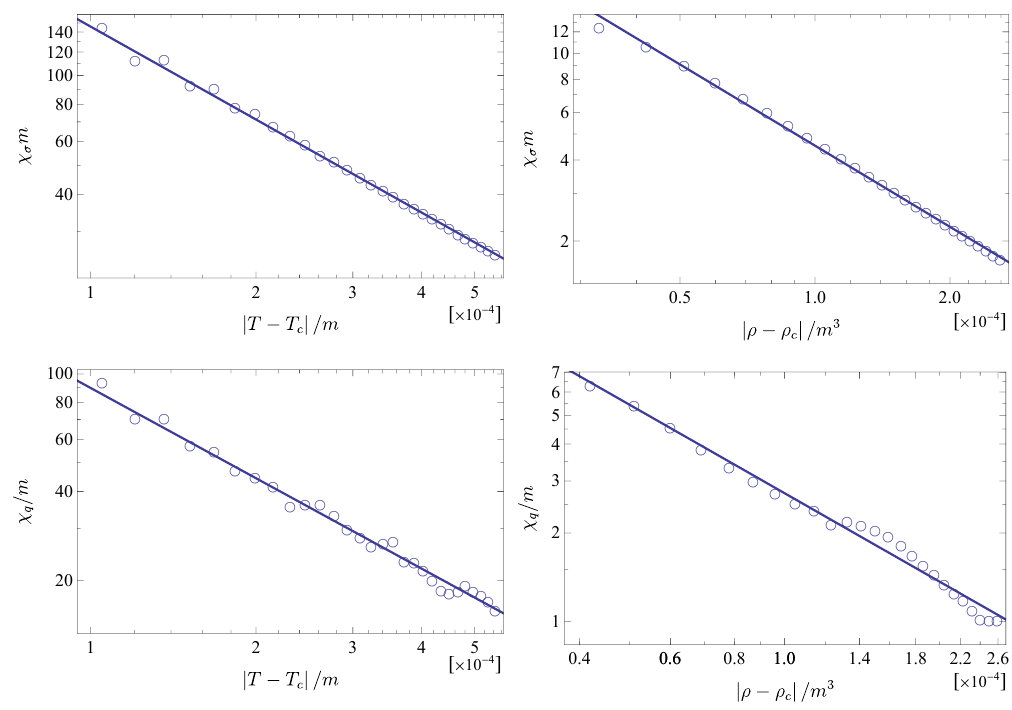
Figure 6 . The critical behaviors of the susceptibilities in the crossover region. The left (right) panels show the results with the susceptibility of the conductivity (the chiral condensate). The open circles and the solid lines denote the numerical plots and the fitting results, respectively.